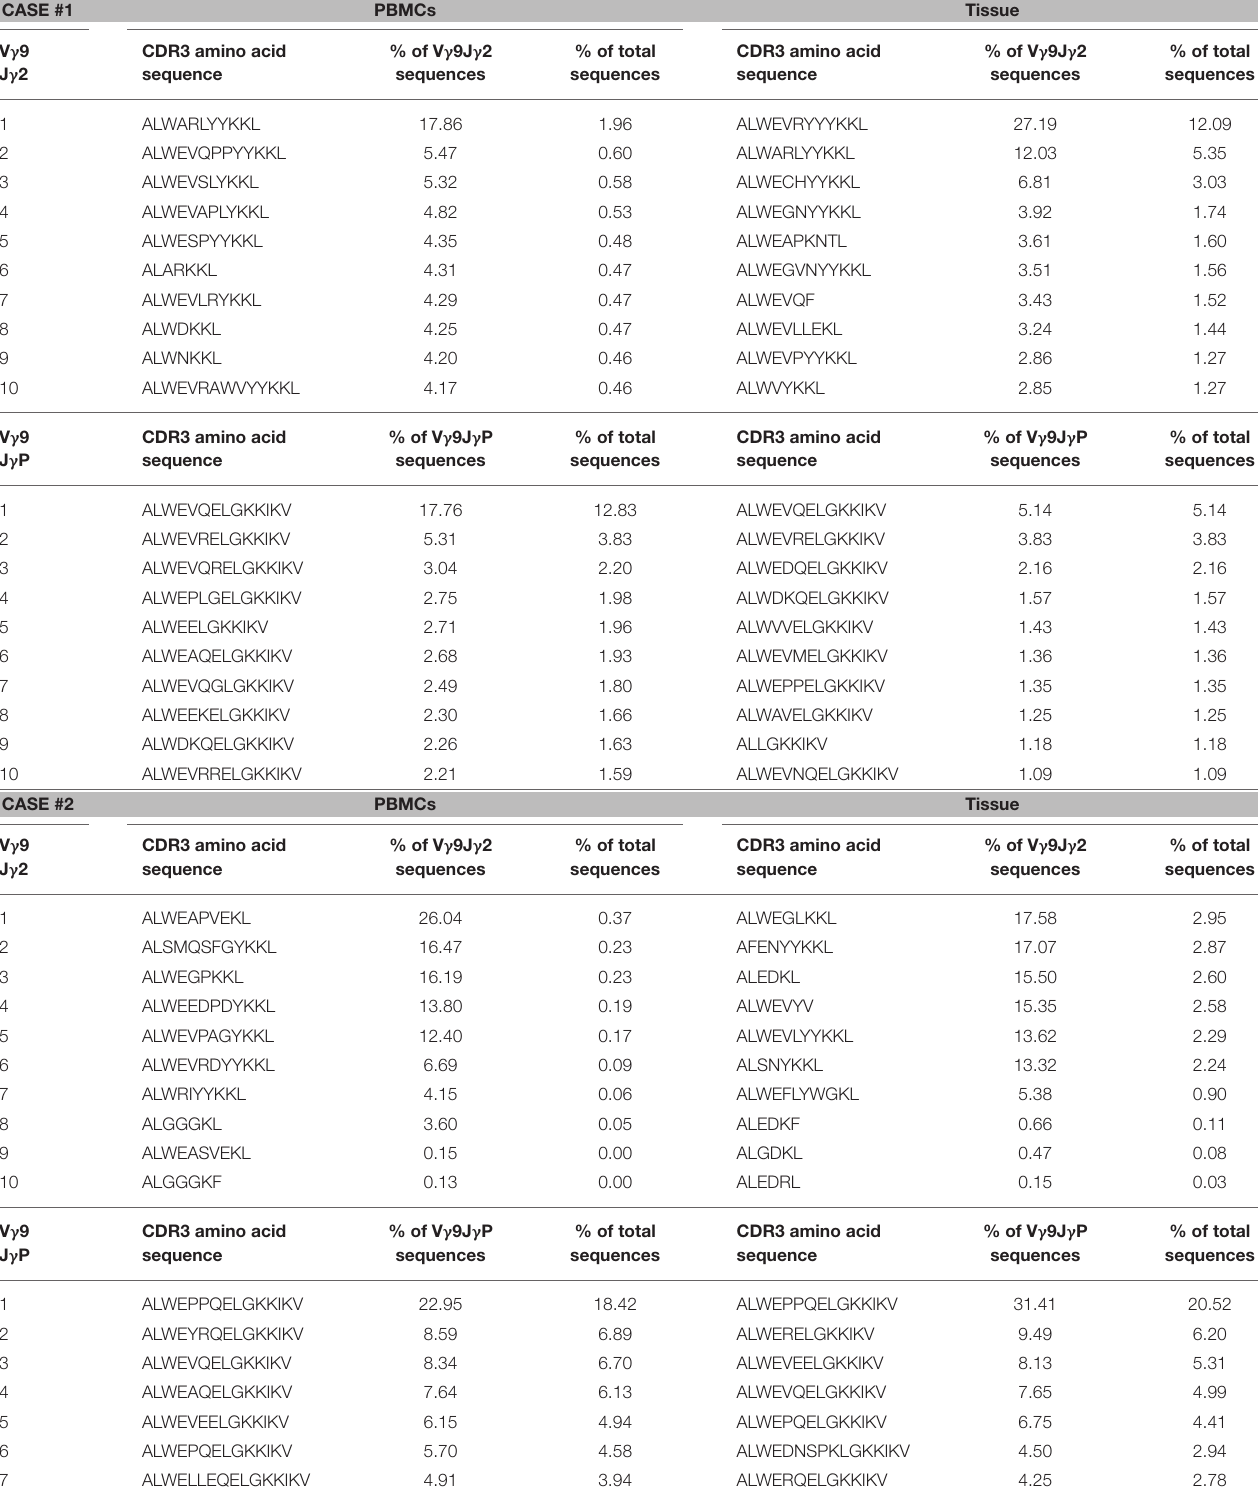
TABLE 3 | TOP 10 CDR3 sequence by the usage proportion of V γ 9J γ 2 or V γ 9J γ P in patient blood and tissue